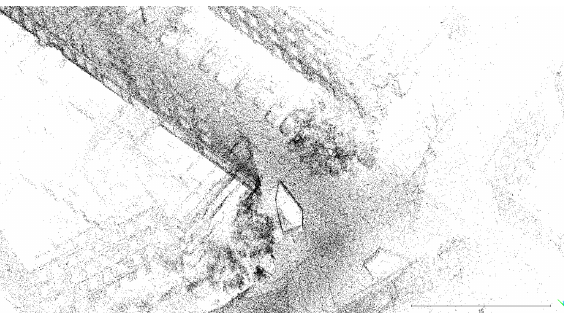
Figure 8. Map point cloud in LOD 4.